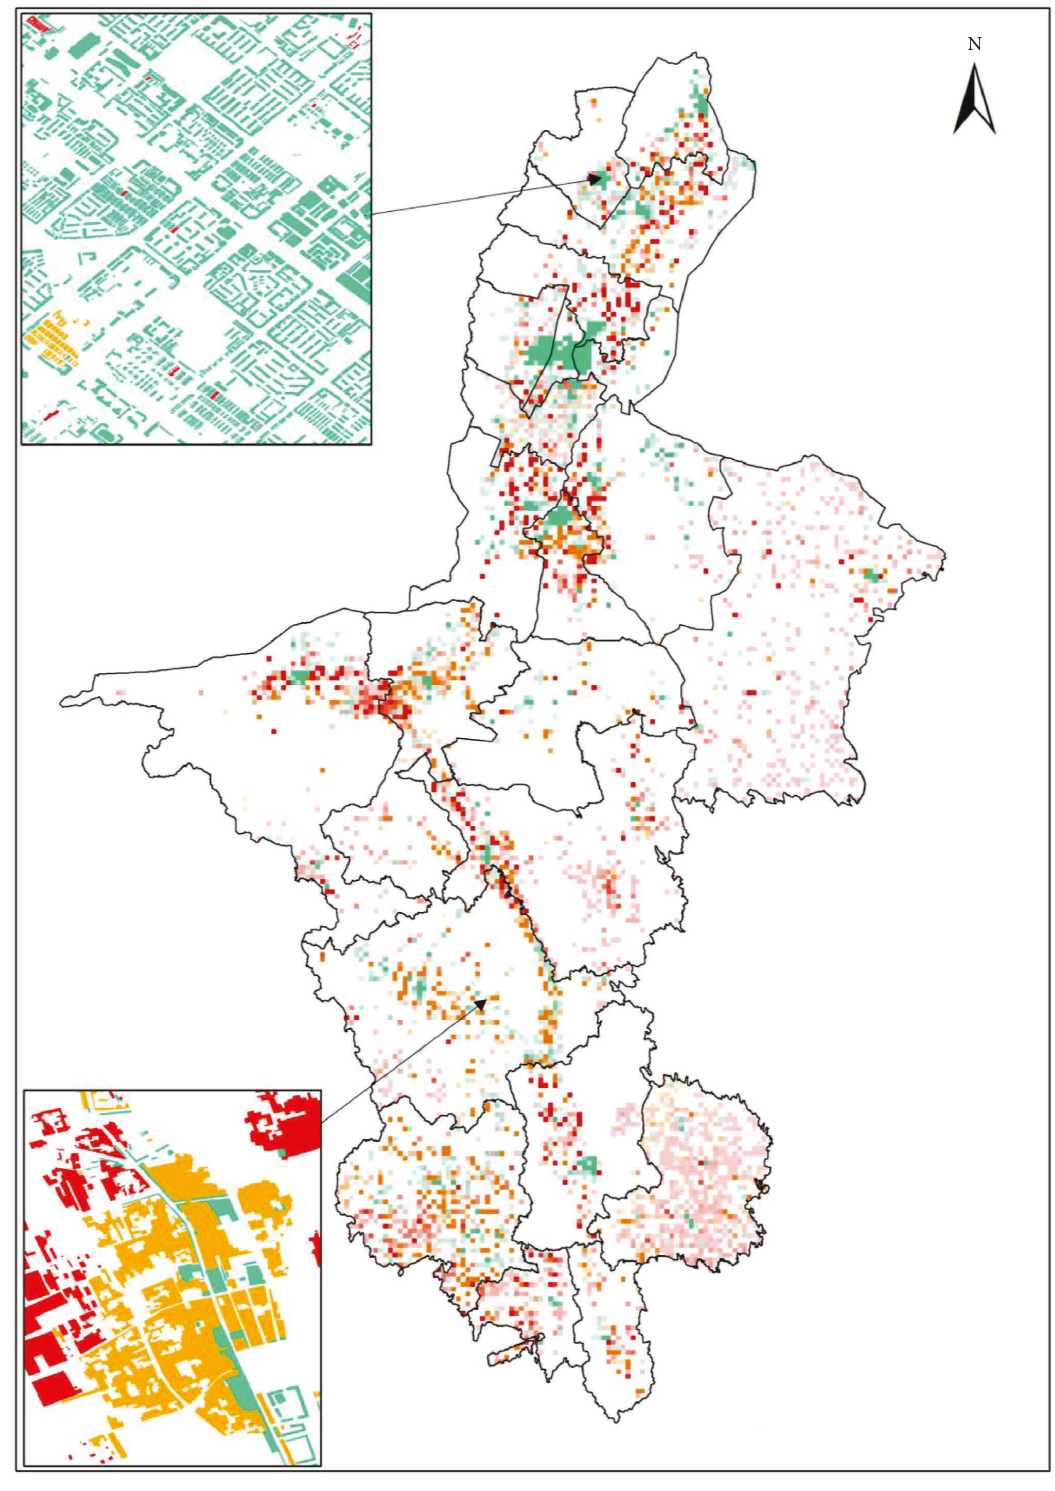
Figure 11: Distribution of the SP of the buildings among the three SP